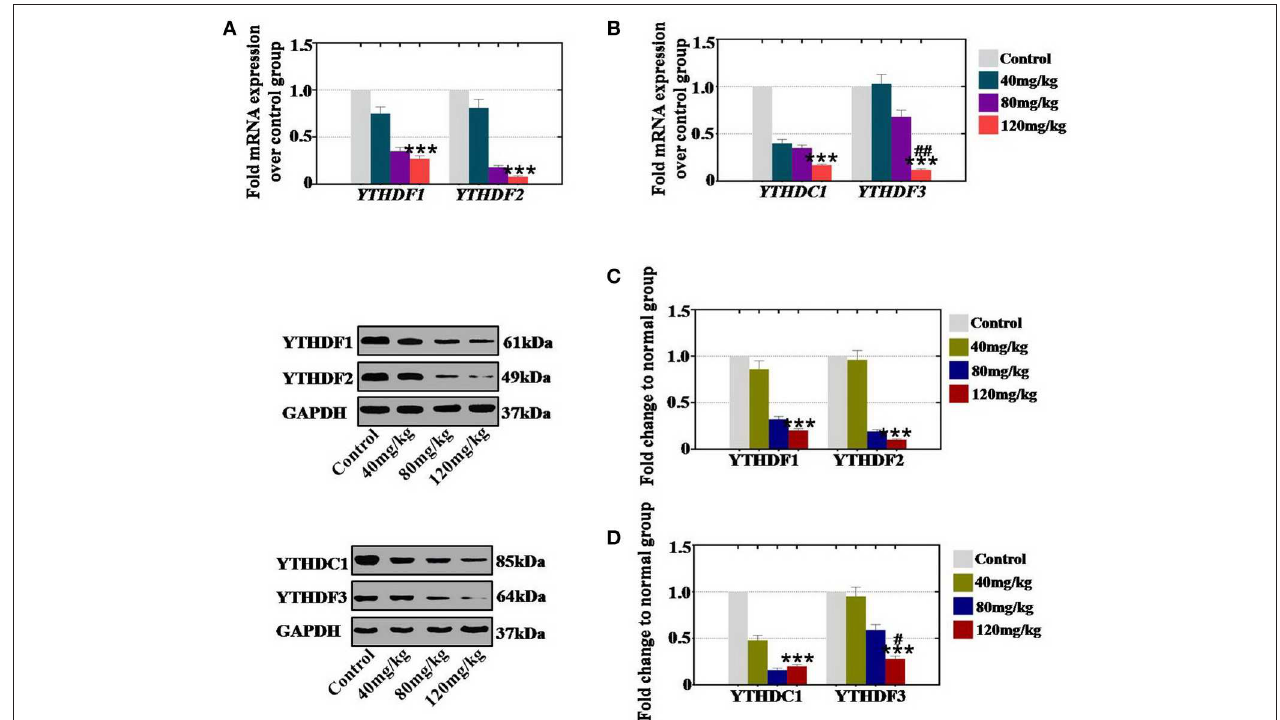
FIGURE 7 | Quantification and concentration-dependence analysis of the RNA effector expression levels after CTX treatment in vitro . (A) The mRNA expression levels of YTHDF1 and YTHDF2 in mouse ovary were measured after treatment with CTX (40, 80, and 120 mg/kg). (B) The mRNA expression levels of YTHDC1 and YTHDF3 in mouse ovary were measured after treatment with CTX (40, 80, and 120 mg/kg). (C) The protein expression levels of YTHDF1 and YTHDF2 in mouse ovary were measured after treatment with CTX with (40, 80, and 120 mg/kg). (D) The protein expression levels of YTHDC1 and YTHDF3 in mouse ovary were measured after treatment with CTX (40, 80, and 120 mg/kg). All experiments were performed three times. The error bars indicate SD; *** p < 0.001 (compared with the control group); # p < 0.05; ## p < 0.01 (compared with the 80 mg/kg CTX concentration group).